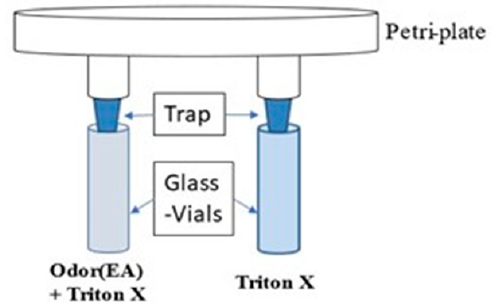
Figure 1. An illustration of an experimental two-choice olfactory assay designed for adult Drosophila flies. The two traps attached to the Petri plate do not allow flies to change their choice, once they enter the glass vial. One glass vial contained 300 µ L of 0.2% Triton X-100 diluted in water (solvent), while the other contained 300 µ L of ethyl acetate odor of 10 − 2 dilution in 0.2% Triton X-100. Earlier, the arsenic-treated flies (at 1 mM, 1.5 mM, and 2 mM) were starved for 4 h along with the control flies. The flies from each set were anesthetized on ice. Once they were anesthetized, forty flies (both males and females) from each set were transferred to different experimental Petri plates. The Petri plates were immediately covered with a lid.